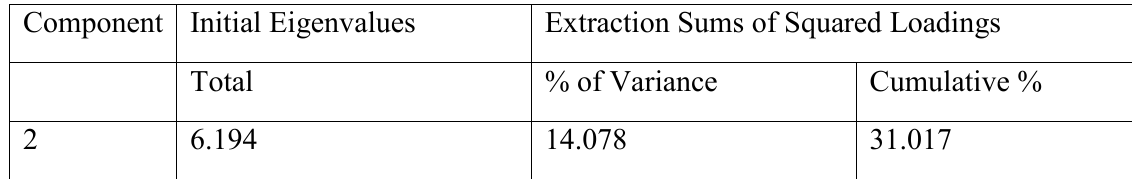
Table 1.3: Variance explained for Absorptive Resilience PC2 Component